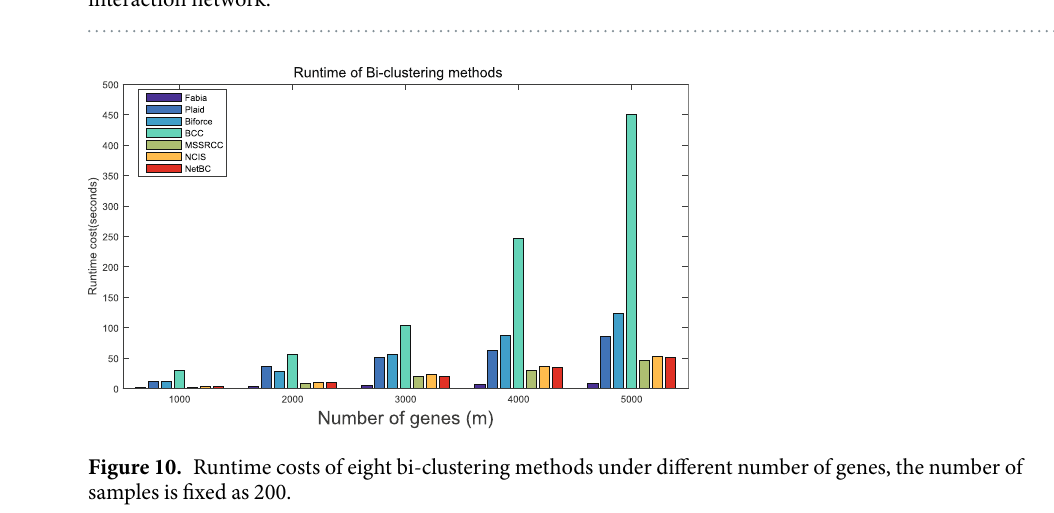
Figure 9. Performance of NetBC and NCIS with randomly added, deleted and rewired edges of gene interaction network.